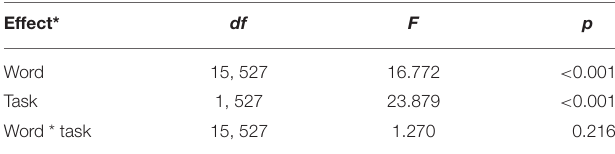
TABLE 3 | Mixed effects ANOVA (rhyme and task) for included words. TABLE 5 | Mixed effects ANOVA (word and task) for included words.